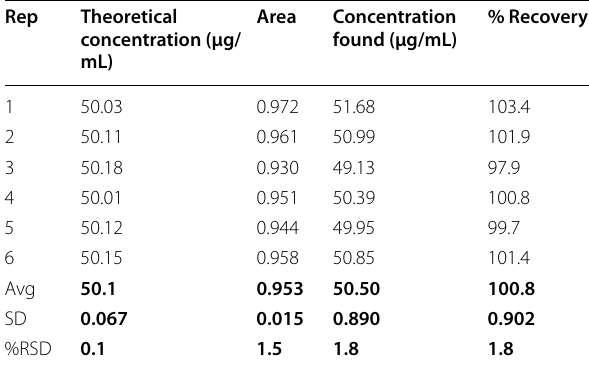
Table 2 Method precision results